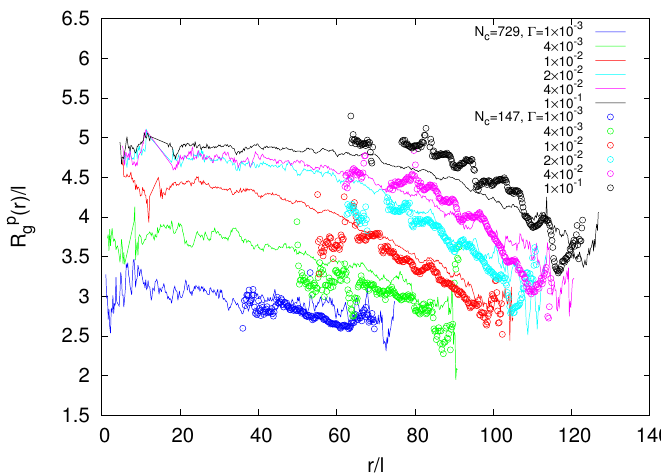
Figure 11. Dependence of the polymer radius of gyration on its radial center-of-mass position r for microgels with N c = 729 and L / l = 400 (lines), and N c = 147 and L / l = 300 (circles). The latter are radially shifted to match the respective microgel surface.